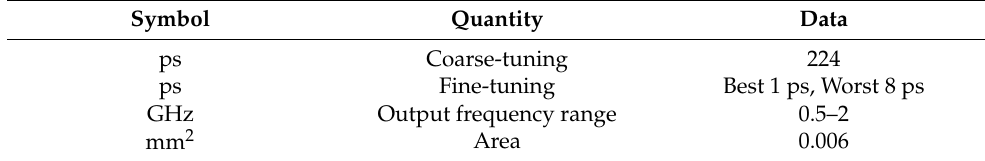
Table 1. DCO post-simulation results.